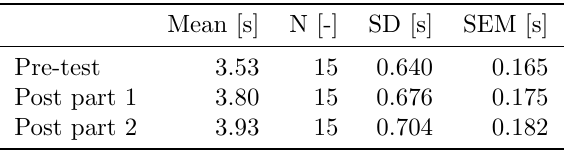
Table 9: Paired samples statistics for survey on trust in